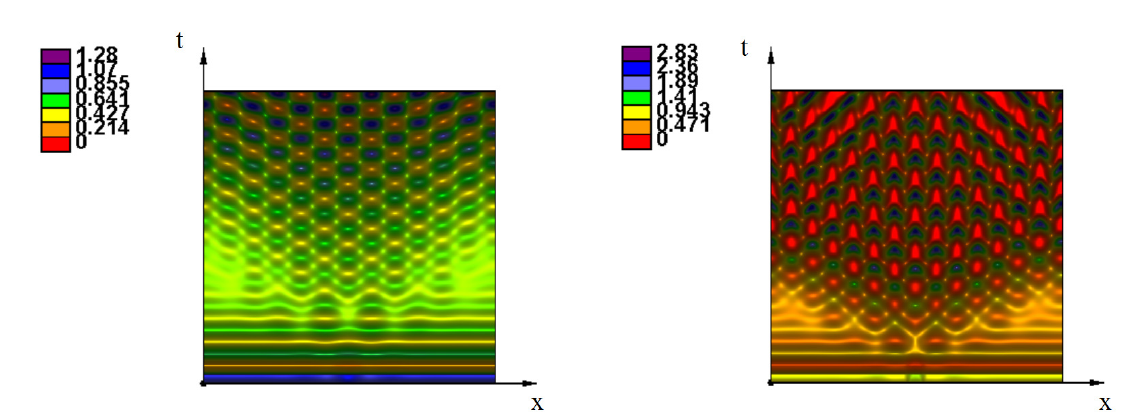
Figure A1. Numerical simulations of Equation (13) for the linear function f ( u ) = k 1 u . Level lines of the solution u ( x , t ) on the plane ( x , t ) ( left ). Two snapshots of solution ( right ). The value of parameters: r = 1, q = 1, k 1 = 0.95, N = 0.1, τ = 4, D = 0.0001 ( left ), D = 0.00001 ( right ), t = 150. Initiation and propagation of periodic